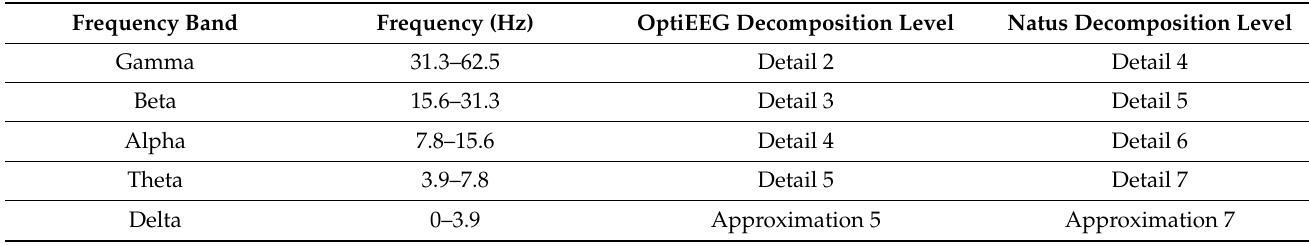
Table 2. DWT decomposition levels and corresponding frequency